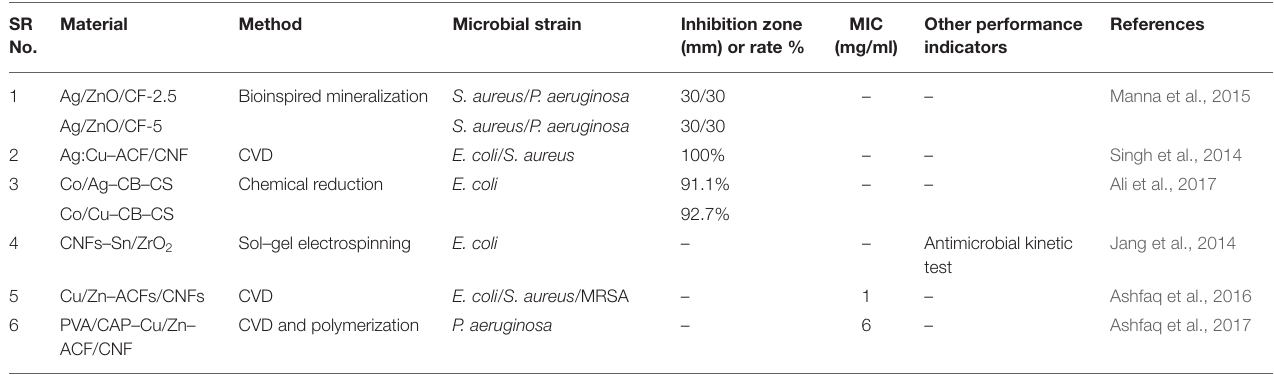
TABLE 3 | Types and antimicrobial properties of fiber-supported bimetallic nanoparticles. SR No.